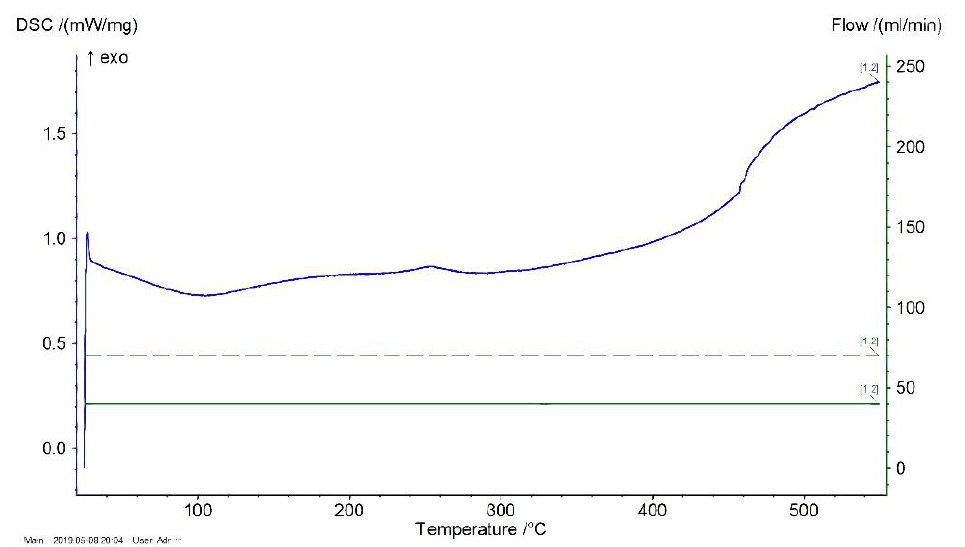
Figure 3. The differential scanning calorimetry (DSC) curve of the varnish/xylene: 1/1 film composition.